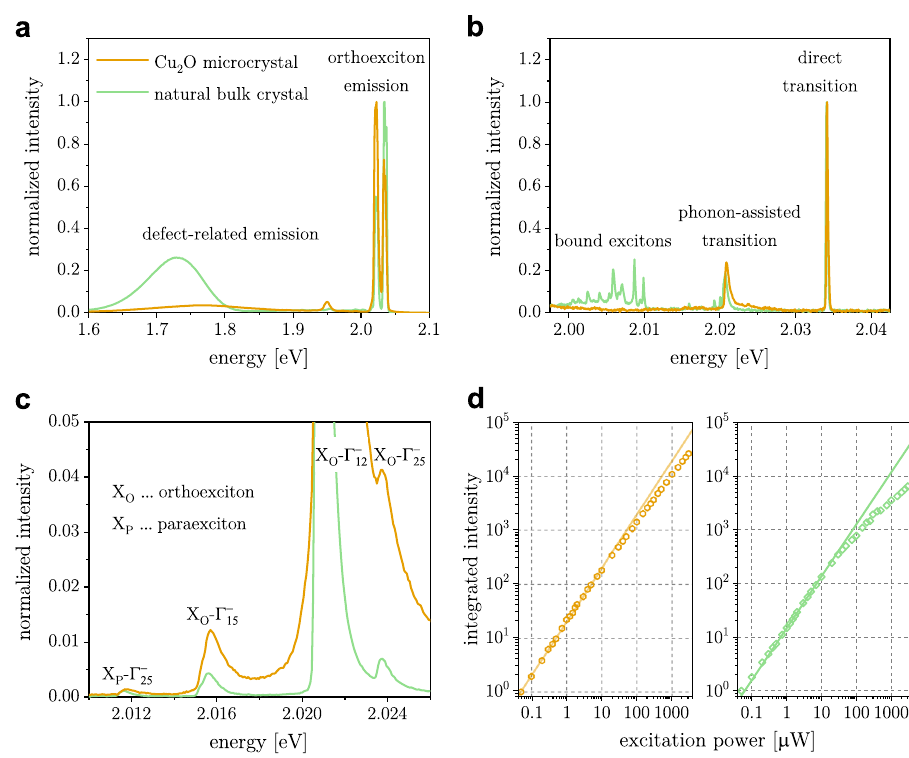
Fig. 2 Photoluminescence spectroscopy of Cu 2 O microcrystals at milli-Kelvin temperatures benchmarked to measurements on a natural bulk crystal. a Normalized photoluminescence of excitons and point defects (excitation power 50 μ W). b Normalized emission from different excitonic transitions and bound excitons at low excitation power of 50 nW. c Phonon-assisted transitions of ortho- and paraexcitons (spectra normalized to direct transition; excitation power 50 μ W). d Excitation power dependence of integrated emission in an energy range covering bound excitons, phonon-assisted transitions and the direct quadrupole line. Solid lines are a linear fi t (Cu 2 O microcrystal, left) and a linear curve as guide to the eye (natural bulk crystal, right),